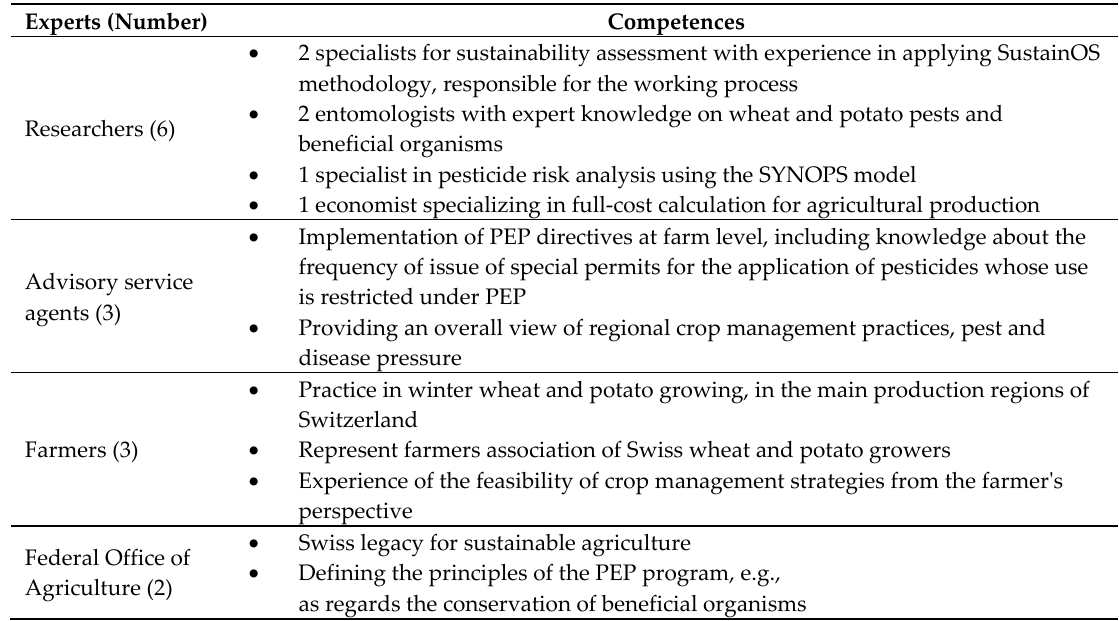
Table 2. Definition of context and target parameters.